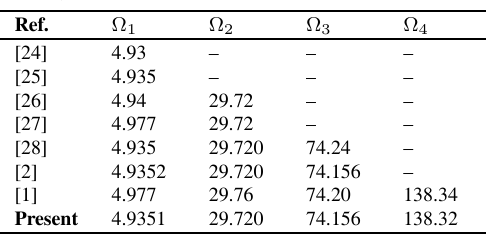
Table 3 Comparison of Ω for isotropic circular plates of uniform thickness with simply supported edge when α = β = 0 and e r = 1